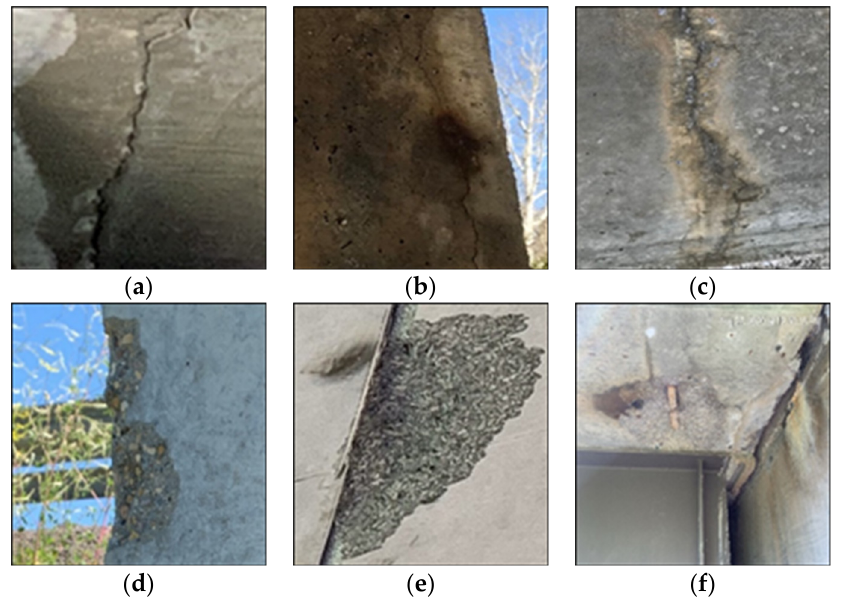
Figure 3. Sample images for defects dataset ( a – c ) crack and ( d – f ) spalling (image courtesy: TBT Engineering). Table 1. Dataset comparison of prior studies and current study.